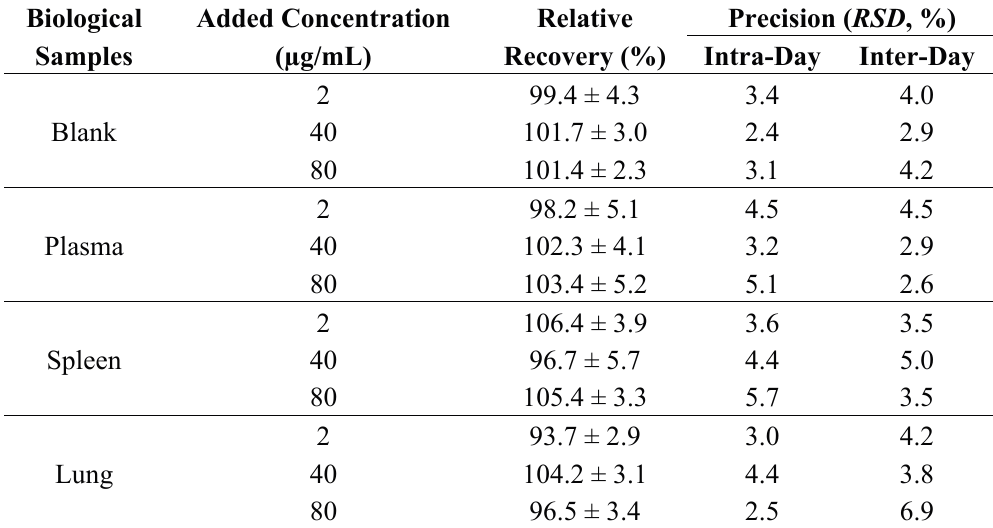
Table 2. Precision and accuracy for quantitative determination of LPPF by high performance size exclusion-fluorescence detection (HPSEC-FD)